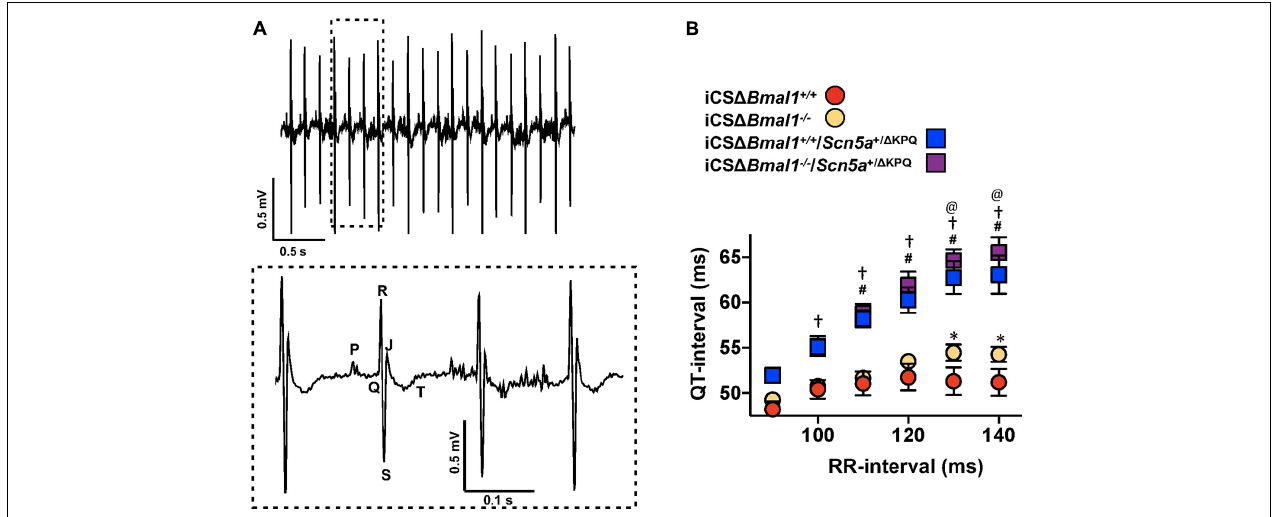
FIGURE 2 | Deletion of Bmal1 in adult cardiomyocytes prolongs the QT-interval at longer RR-intervals. (A) Representative electrocardiogram trace measured from the mice used in this study. The inset shows the dashed box region on the ECG trace in more detail to highlight the P, Q, R, S, J, and T waves. (B) The mean QT-interval plus standard error of the mean measured between 90 and 140 ms in iCS (cid:49) Bmal1 + / + (red circles), iCS (cid:49) Bmal1 + / + /Scn5a + /(cid:49) KPQ (blue squares), iCS (cid:49) Bmal1 − / − (orange circles) or iCS (cid:49) Bmal1 − / − /Scn5a + /(cid:49) KPQ (purple squares) mice is shown ( n = 6 and n = 8, respectively). We compared QT intervals at each RR-interval between iCS (cid:49) Bmal1 + / + and iCS (cid:49) Bmal1 + / + /Scn5a + /(cid:49) KPQ ( # p < 0.05); iCS (cid:49) Bmal1 − / − or iCS (cid:49) Bmal1 − / − /Scn5a + /(cid:49) KPQ ( † p < 0.05); iCS (cid:49) Bmal1 + / + and iCS (cid:49) Bmal1 − / − (* p < 0.05); and iCS (cid:49) Bmal1 + / + /Scn5a + /(cid:49) KPQ and iCS (cid:49) Bmal1 − / − /Scn5a + /(cid:49) KPQ ( @ p <